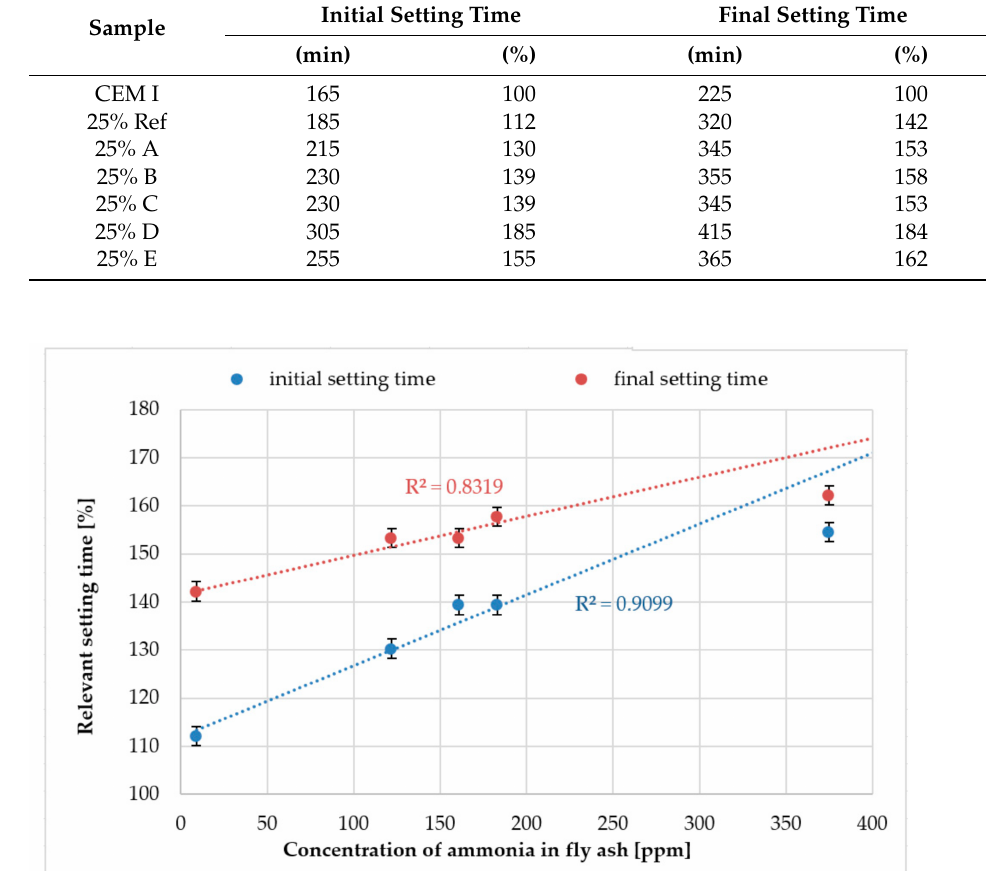
Figure 5. Correlation between ammonia content and relevant setting time.